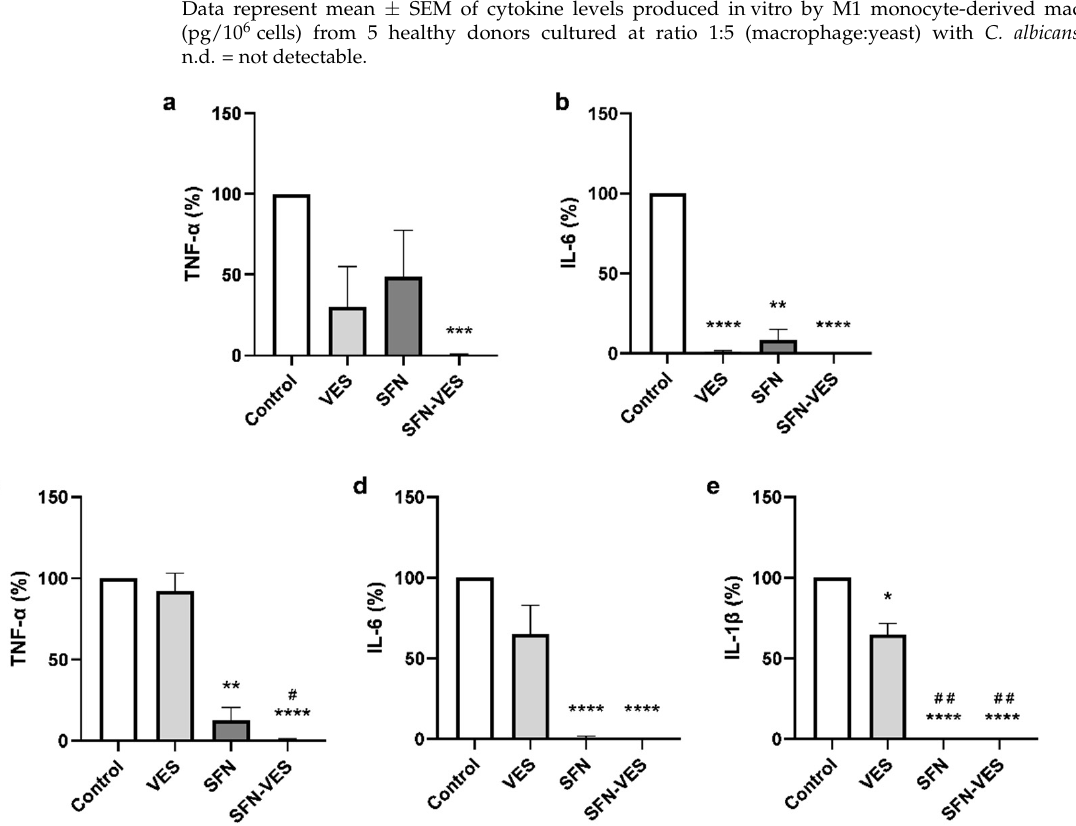
Table 2. Cytokine production induced by C. albicans in human monocyte-derived M1 macrophages. Cytokine State Treatment (pg/10 6 cells) TNF- α IL-6 Control Basal 563.3 ± 232.1 - Control 229.0 ± 96.3 Inflammatory (LPS-induced)